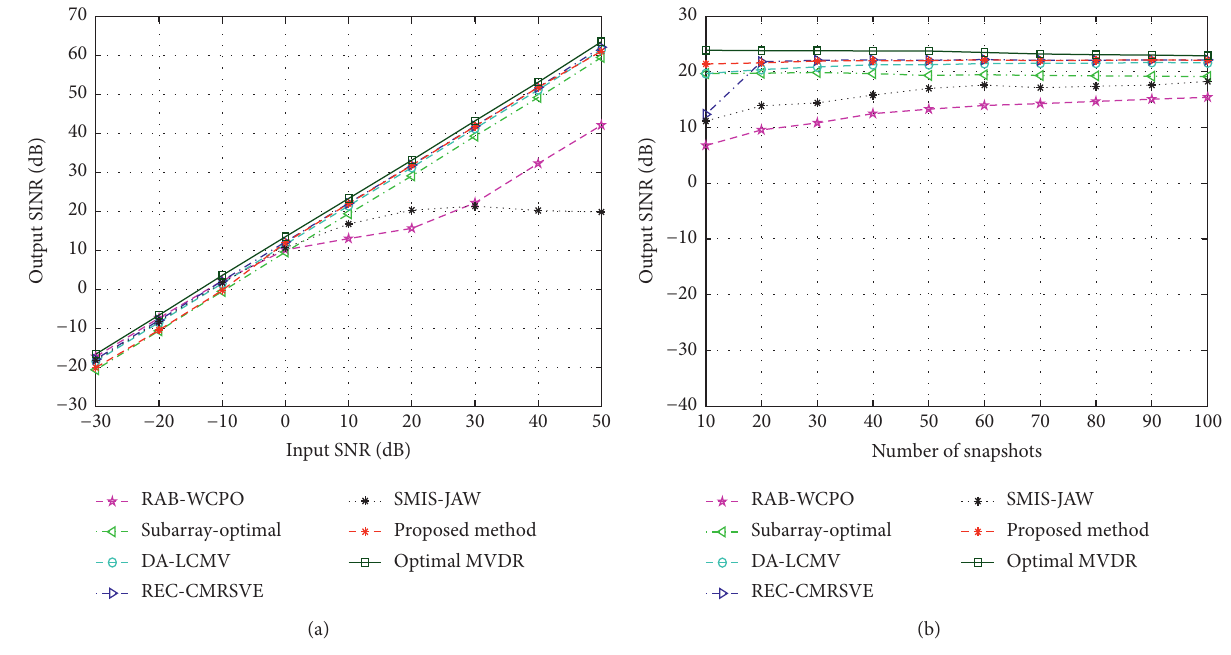
Figure 6: Third example: (a) output SINR versus input SNR and (b) output SINR versus number of